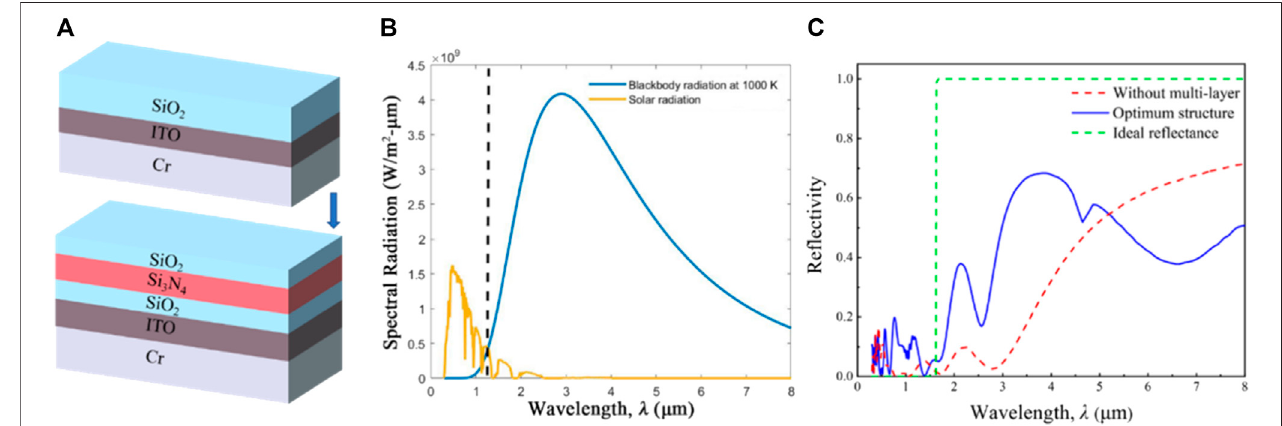
FIGURE 1 | (A) Schematic diagram of the multilayer fi lm structure formed by alternate deposition of Cr, ITO, SiO 2 , and Si 3 N 4 . (B) Solar and blackbody spectral radiation. (C) Spectral re fl ectance of the base structure, optimized and ideal one.